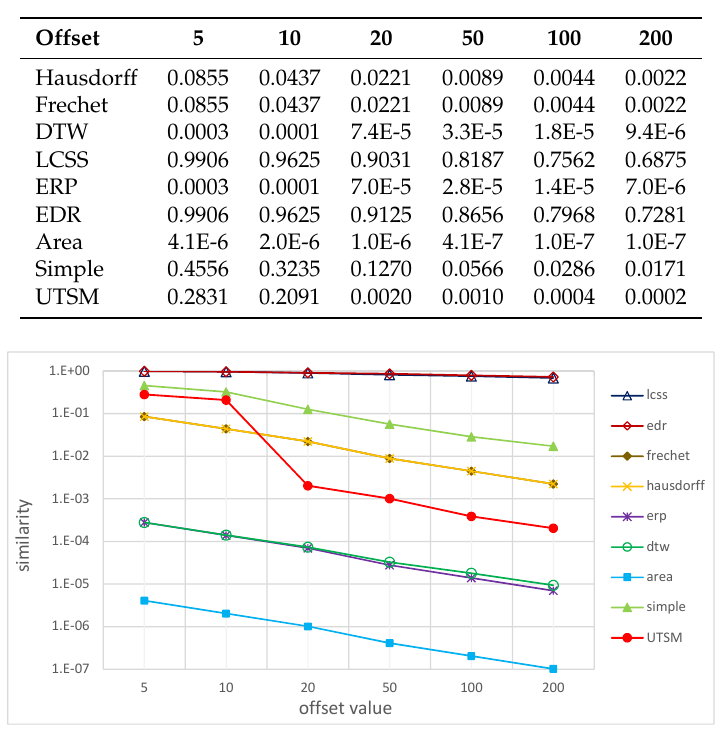
Figure 12. Similarities between trajectories with different